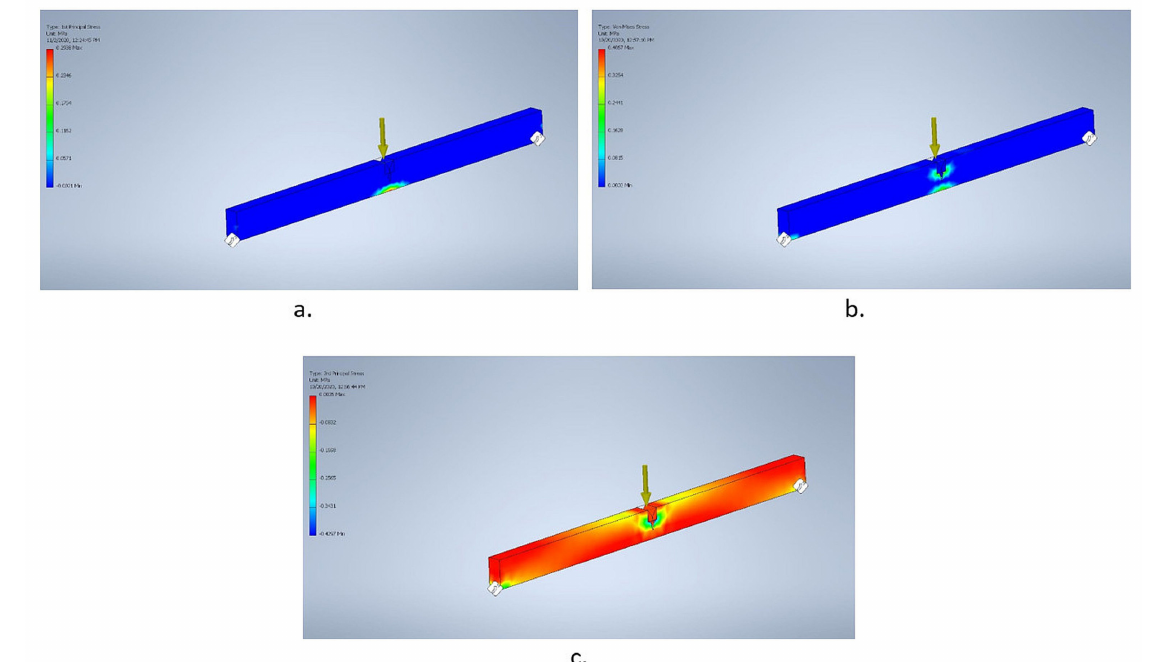
Figure 9. Results from the computer simulation on product sample: ( a ) 1st principal stresses; ( b ) Von Misses stresses; ( c ) 3rd principal